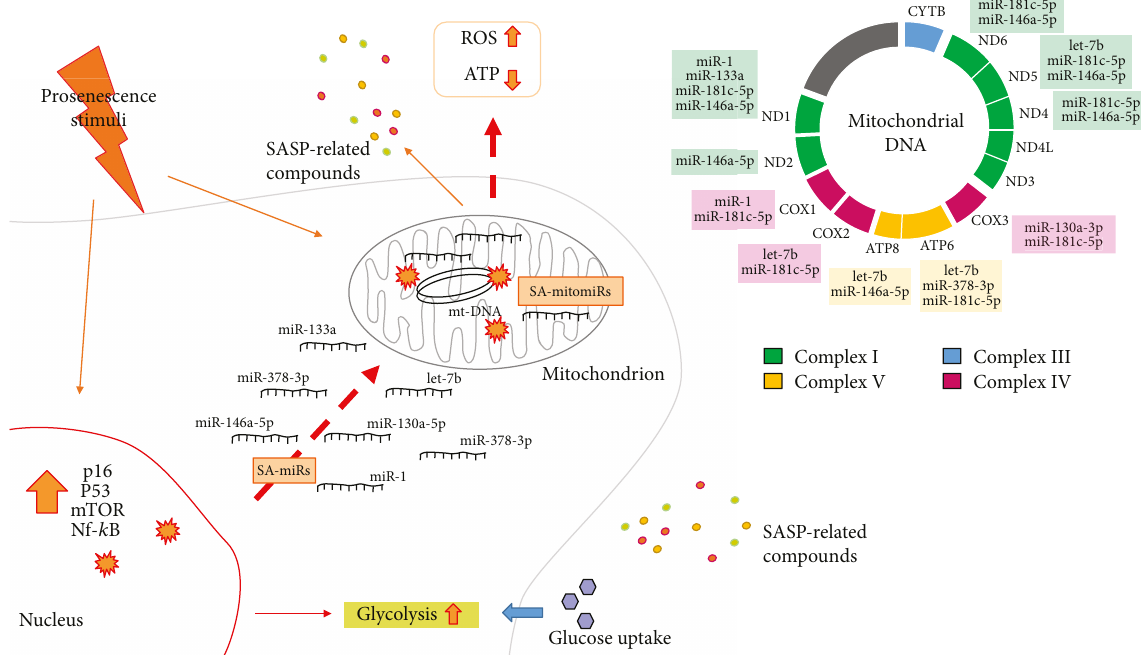
Figure 1: Potential e ff ect of senescence-associated epigenetic rearrangement on mitochondrial function. Di ff erent damaging stimuli can induce senescence. Senescent cells bear peculiar metabolism and gene expression, which underlie a chronic proin fl ammatory program (SASP). This is accompanied by changes in the expression of a number of senescence-associated microRNAs (SA-miRNAs). Dysfunctional mitochondria play a major role in the promotion of the SASP. In turn, several SA-miRNAs can translocate to mitochondria (mitomiRs) and could target a plethora of mRNA with an important role within mitochondria, including transcripts derived from mitochondrial DNA (mtDNA). In this framework, we hypothesize a major role for SA-mitomiRs in determining the energetic, metabolic, and in fl ammatory status of senescent cells, mainly through their ability to regulate mtDNA-derived